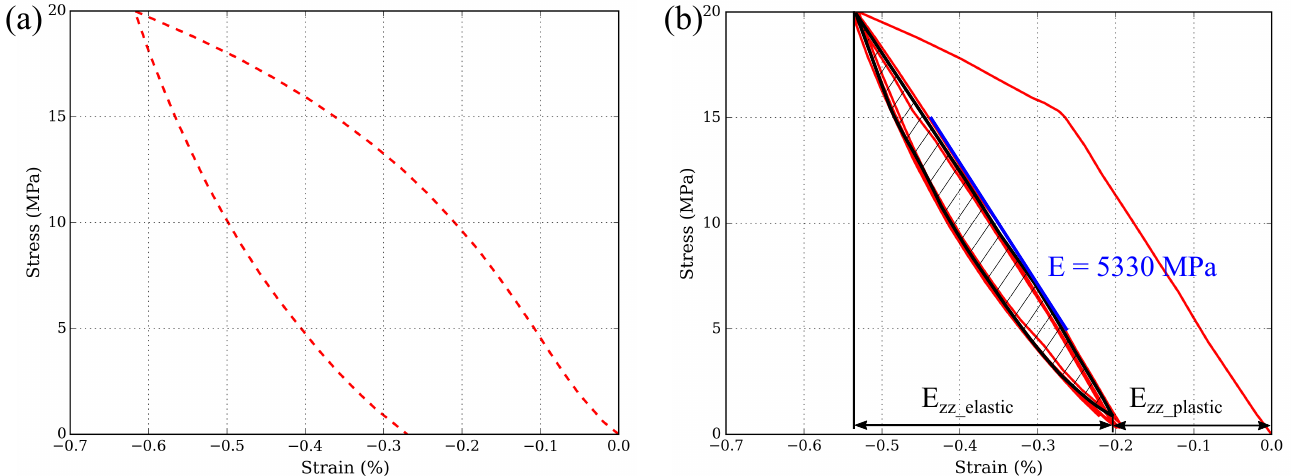
Figure 4. ( a ) Compressive stress-strain (E zz ) curve of a RM specimen directly tested between 0 and 20 MPa. ( b ) Compressive stress-strain (E zz ) curve of a RM specimen after prior testing between 0 and 15 MPa. The area of the hysteresis loop is indicated in